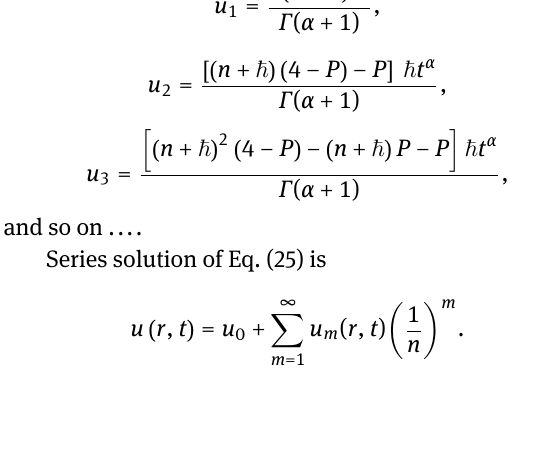
Fig. 7: Plots of q-HATM solution u ( r , t ) Vs. r , t when P = 1, (cid:126) = −1, n = 1, (a) α = 0.5 , (b) α = 1, for Ex. 4.2.